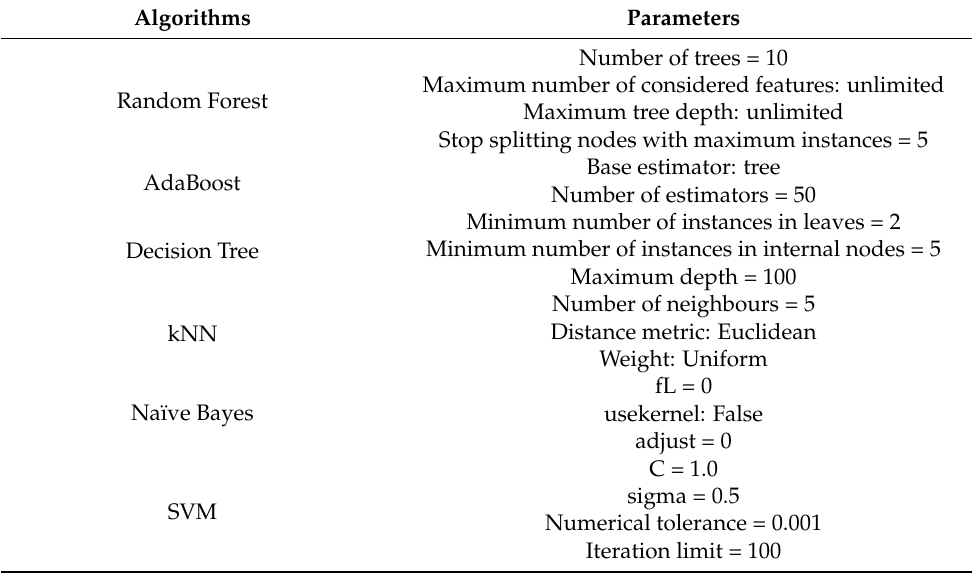
Table 2. Parameters of the machine learning algorithms used in the